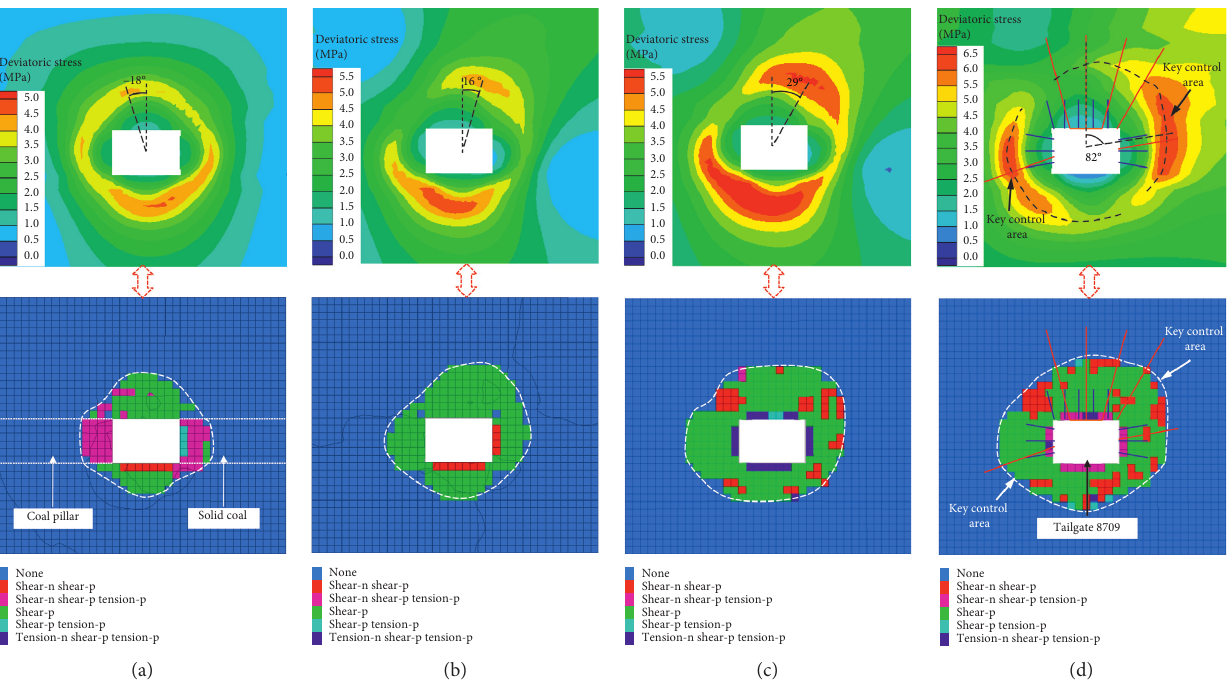
Figure 10: Nephograms of deviatoric stress and plastic zone of Tailgate 8709 under multi-coal-seam mining: (a) after mining of the N8707 coal face in No. 7-4 coal seam; (b) after mining of the N8709 coal face in No. 7-4 coal seam; (c) after mining of the N8707 coal face in No.11 coal seam; (d) in the advance 10 m of the N8709 coal face in No. 11 coal